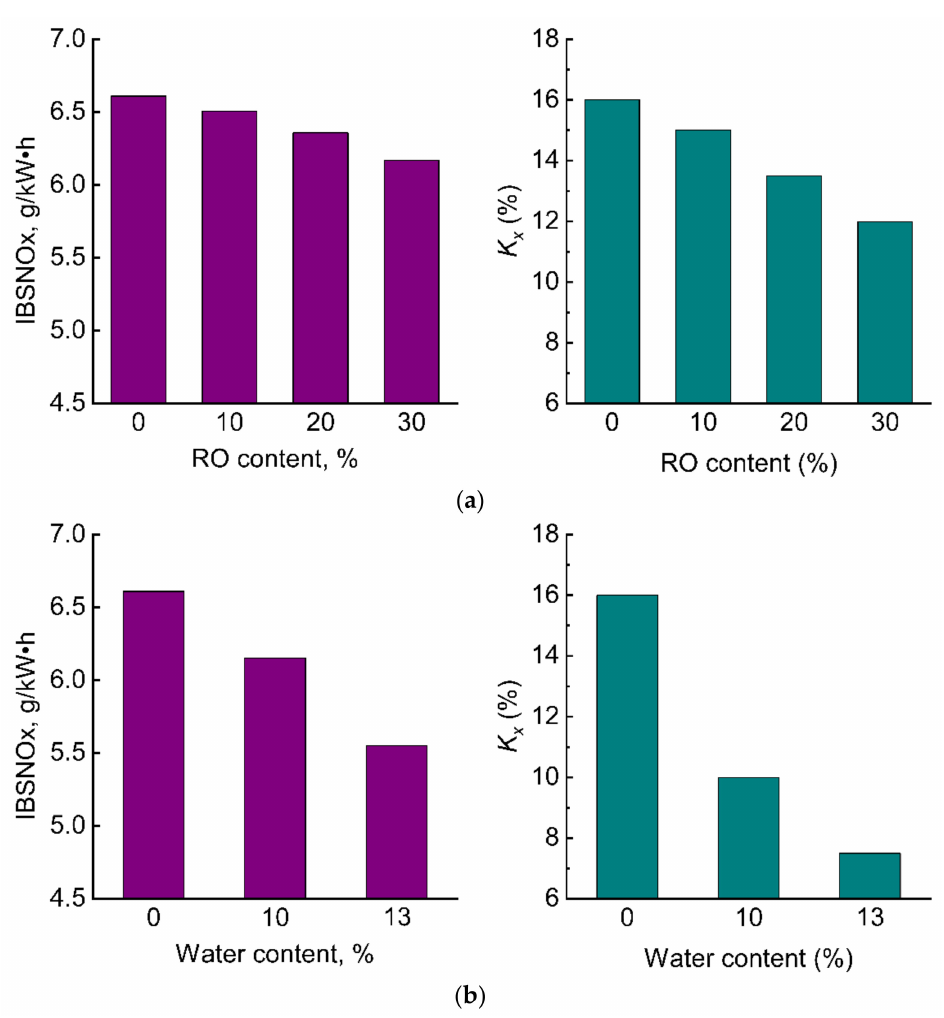
Figure 10. IBSNOx over the 13 modes and the exhaust smoke opacity K X in the maximum power mode for DF-RO blend with different RO content ( a ) and for emulsified DF-RO blend with different water content ( b